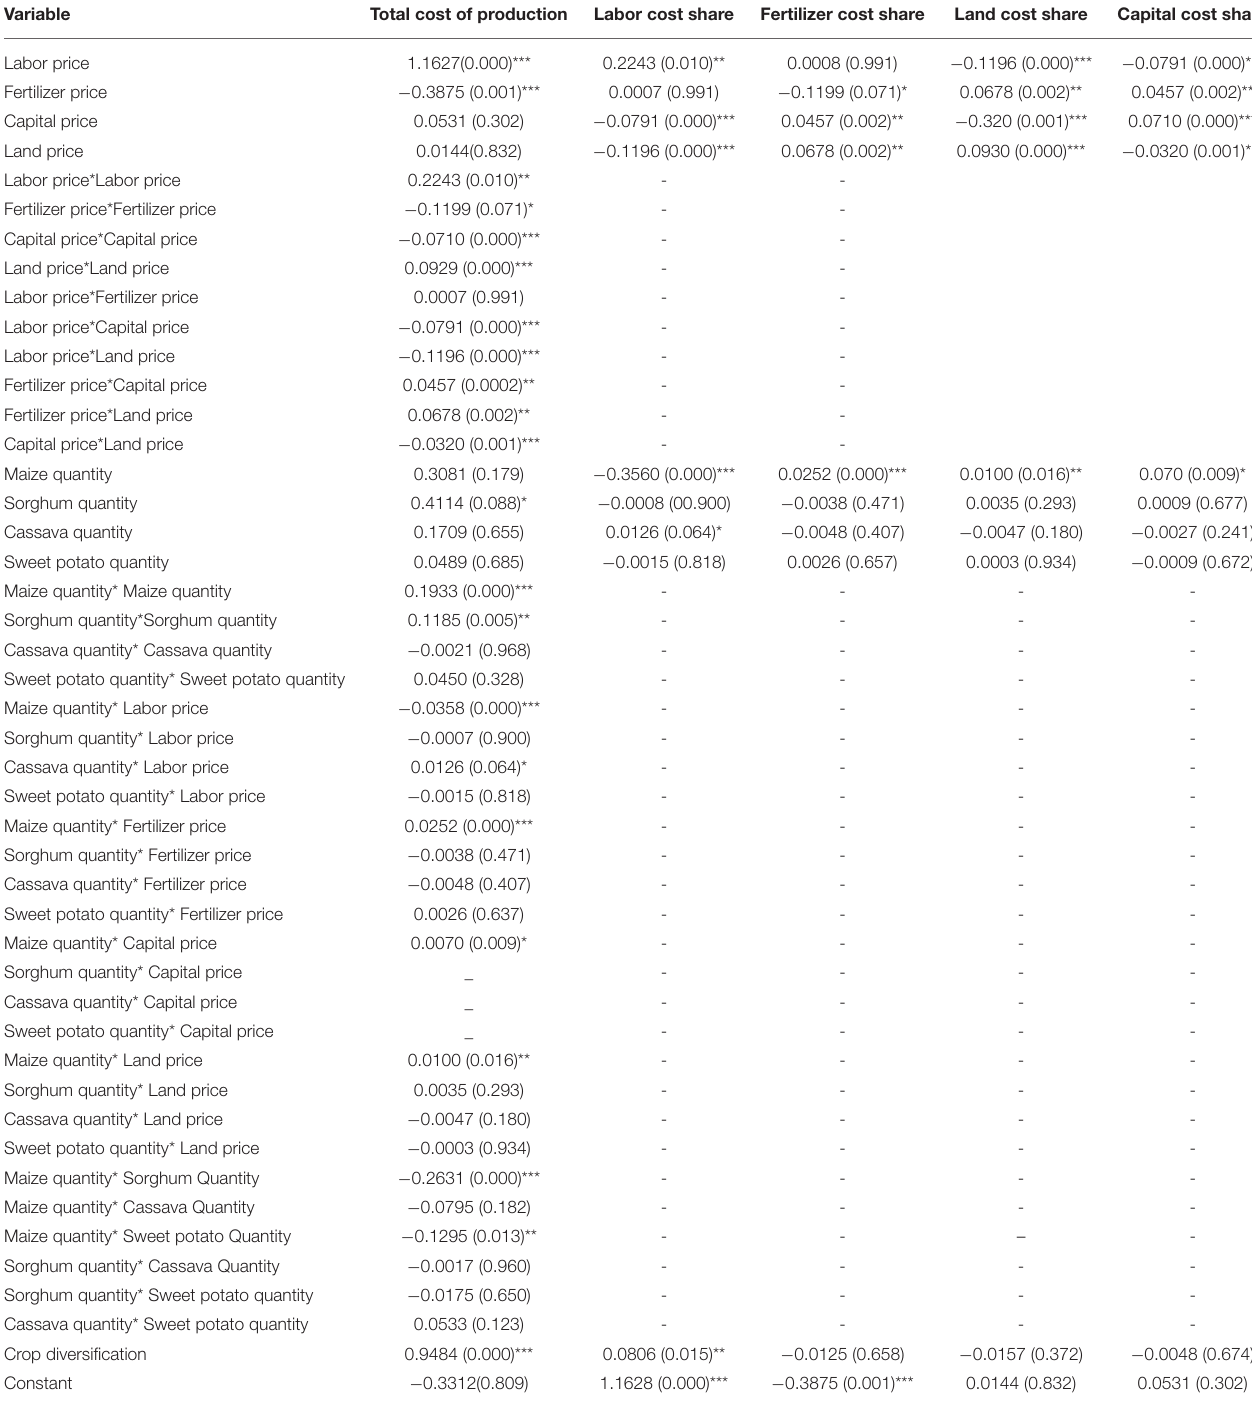
TABLE 4 | Results of the seemingly unrelated regression model for demand estimation.